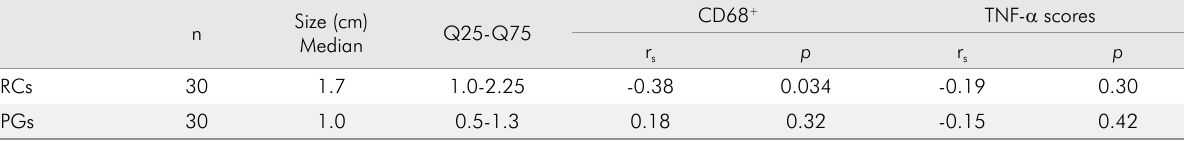
Table 6. Correlation between size and immunoexpression scores of CD68 and TNF- α in RCs and PGs. CD68 + TNF- α scores Size (cm) n Q25-Q75 Median